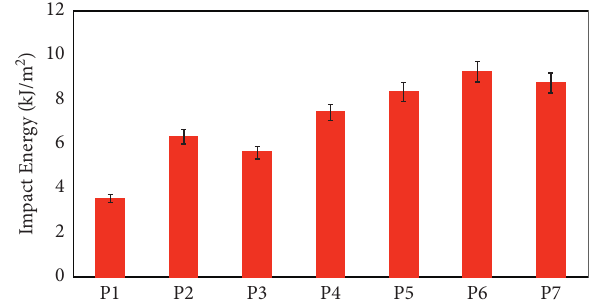
Figure 11: The impact energy of nanosilica particles filled hybrid composites.